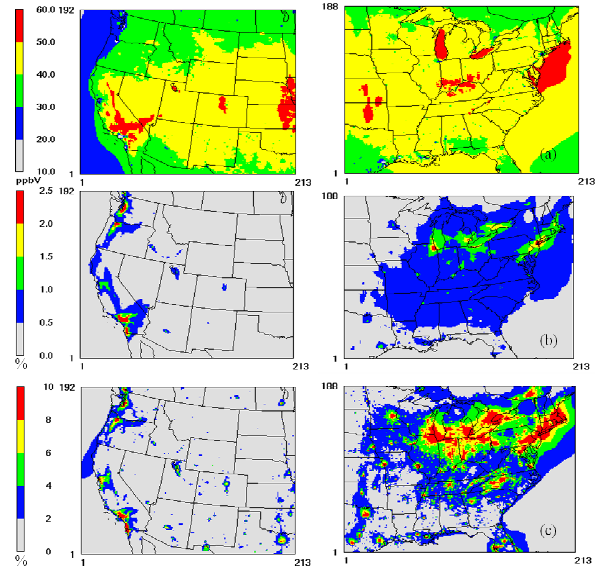
Fig. 2. (a) Monthly mean O 3 with CB05-Base (b) percent increases in mean O 3 between CB05- TU and CB05-Base (c) toluene/VOC